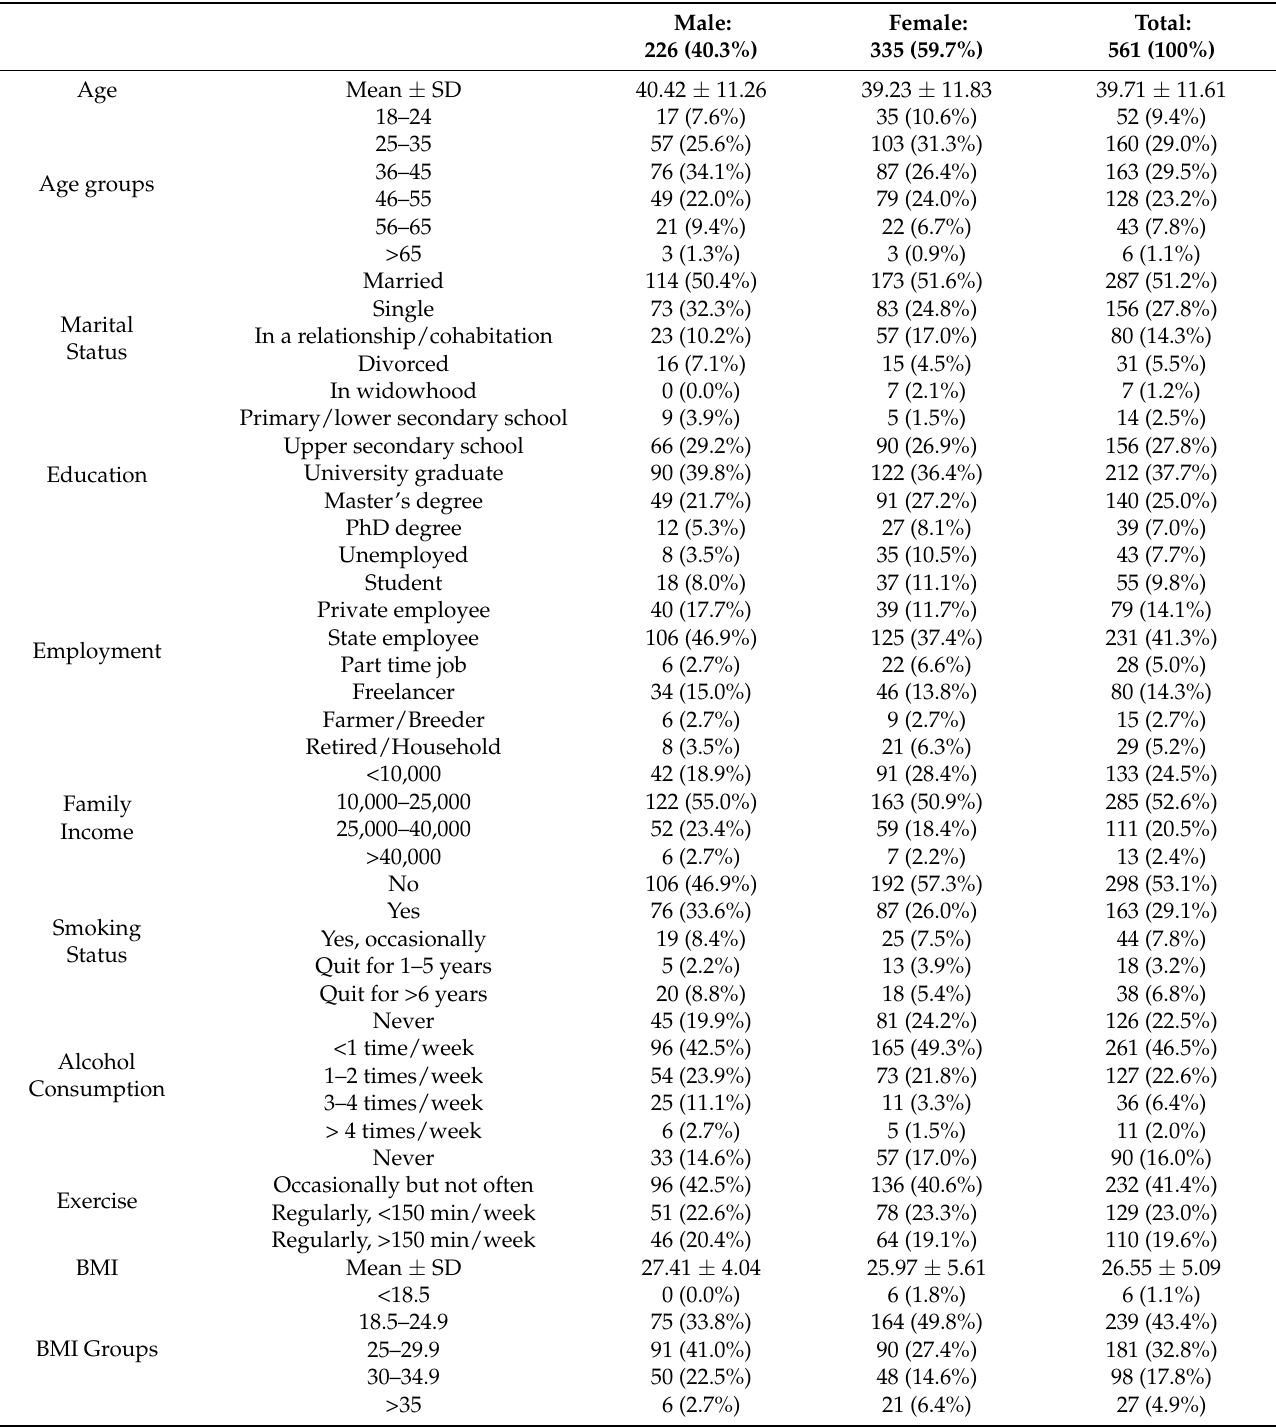
Table 1. General demographics and socioeconomic distribution of the